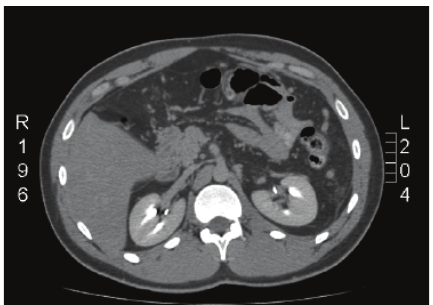
Figure 1: Left renal vein thrombosis with filling defect.